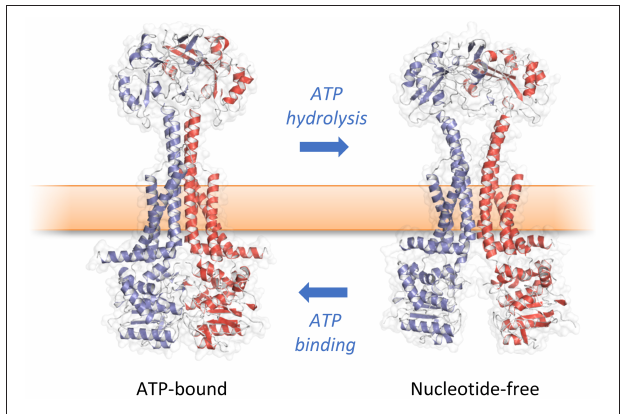
FIGURE 6 | Mechanotransmission mechanism of MacB. ATP binding and hydrolysis cause large, transmembrane conformational changes in MacB structure. Rather than transporting substrates across the inner membrane, MacB-like proteins coordinate reversible dimerization of their NBDs with periplasmic conformational changes. TEP-forming MacB homologs use periplasmic conformational change to drive substrates across the bacterial outer membrane via TolC-like exit ducts. MacB homologs that do not form TEPs are proposed to use similar motions during lipoprotein trafficking and transmembrane signaling. Adapted from Crow et al.